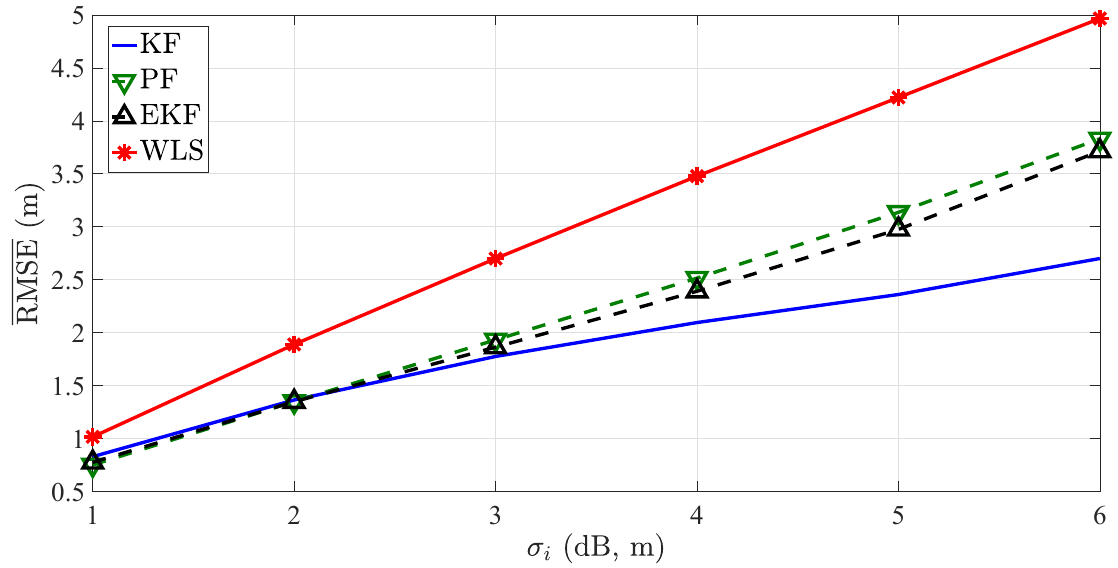
Figure 7. RMSE versus σ i (dB, m) comparison, when N = 4, |L NLOS | = 4, bias max = 1 (dB, m), bias i ∼ U [ 0,bias max ] , B = 30 m.